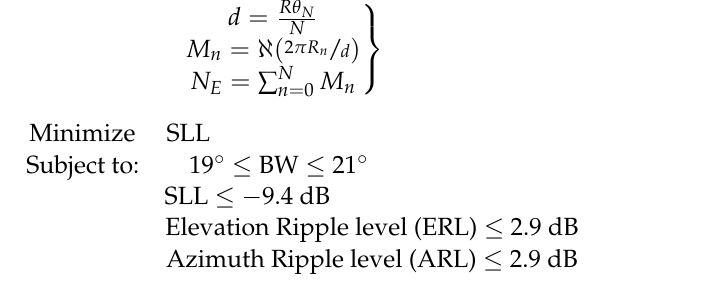
Table 5. Final range of values for the design variables for SA.